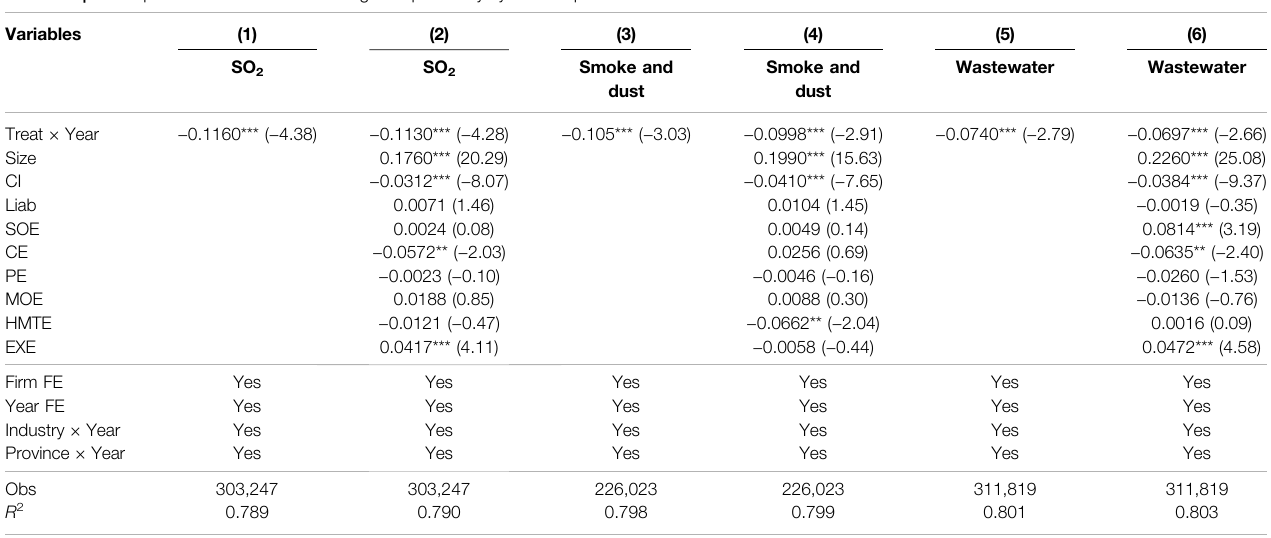
TABLE 3 | The impact of the environmental target responsibility system on pollutant